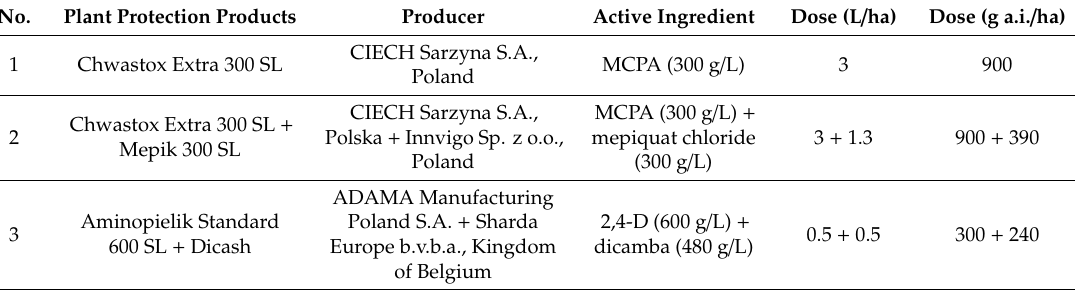
Table 1. Herbicides applied in experiment II and